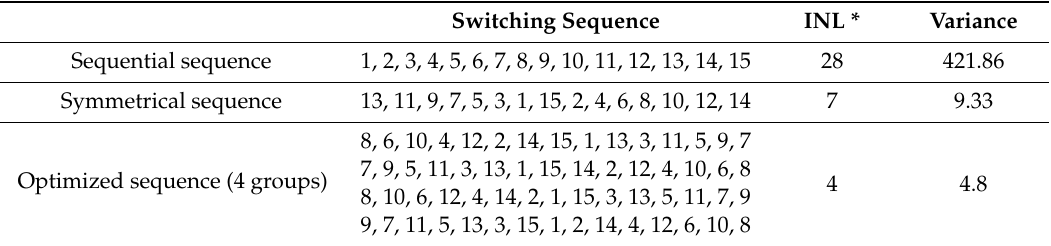
Table 1. Performance comparison of di ff erent switching sequences for one-dimensional 1 × 15